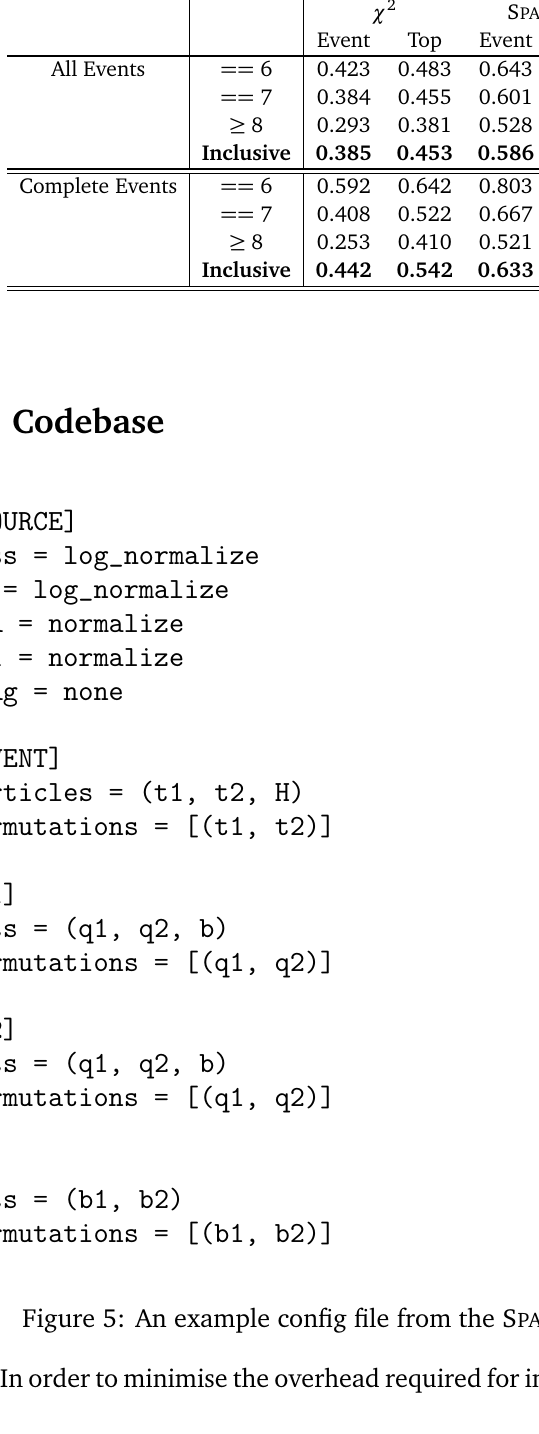
Table 4: Comparison of results on t ¯ t using Pythia and Herwig showering. N jets Pythia8 Herwig7 χ 2